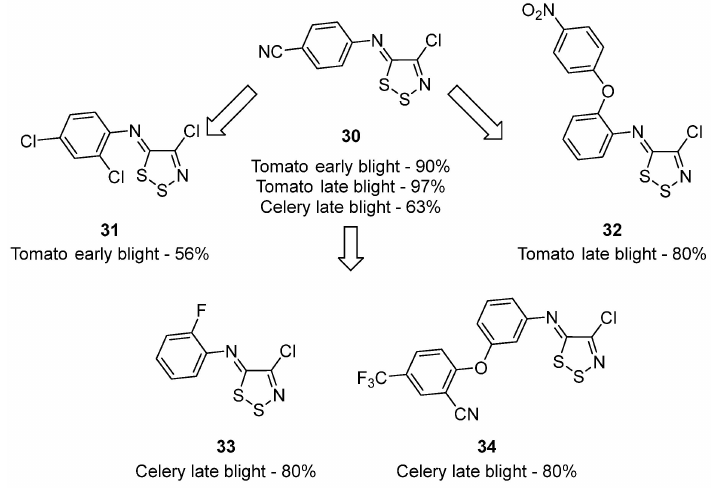
Figure 2. Antifungicidal activities of early 1,2,3-dithiazole derivatives at a concentration of 250 ppm.